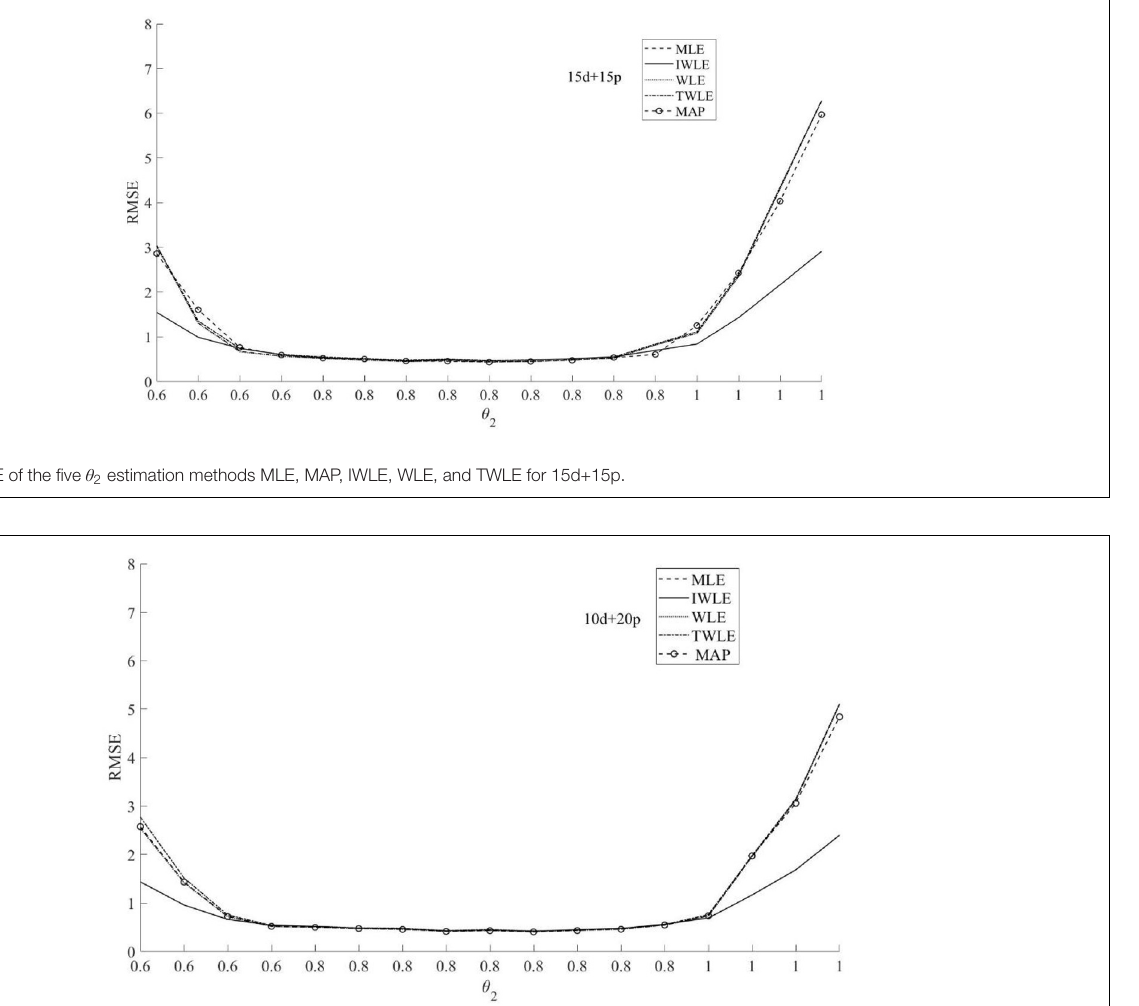
FIGURE 8 | RMSE of the five θ 2 estimation methods MLE, MAP, IWLE, WLE, and TWLE for 10d+20p.